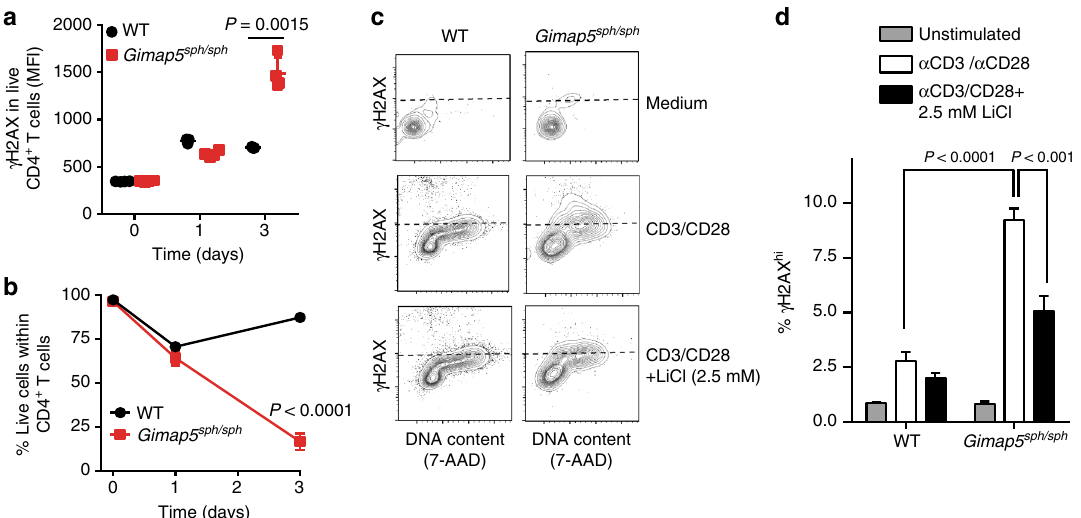
Fig. 4 Loss of Gimap5 causes increased DNA damage in activated CD4 + T cells. a γ H2AX expression in live WT or Gimap5 sph/sph CD4 + T cells following α CD3/ α CD28 stimulation. b Survival as determined by viability stain of WT or Gimap5 sph/sph CD4 + T cells after α CD3/ α CD28 stimulation ( n = 4). Effect of lithium on γ H2AX expression in WT or Gimap5 sph/sph CD4 + T cells, after 3 days stimulation with α CD3/ α CD28. Plots depict live cells ( c , d ), while bar graphs ( d ) represent mean values ± SD ( n = 6). All experiments were performed at least three times. Statistical signi fi cance is determined by Student ’